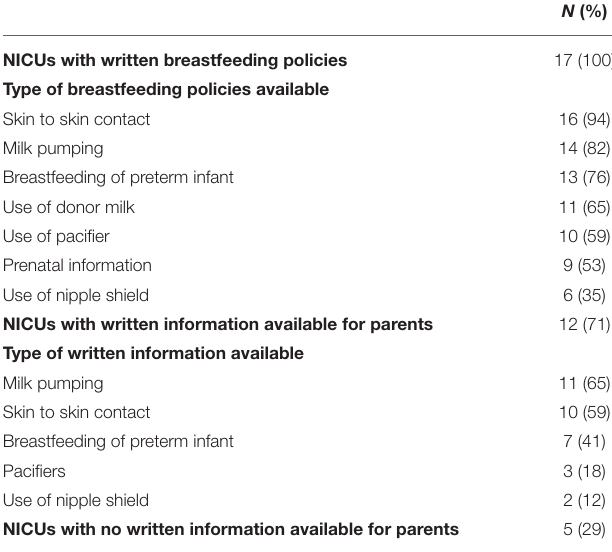
TABLE 3 | Written breastfeeding policies available for staff and written information available for